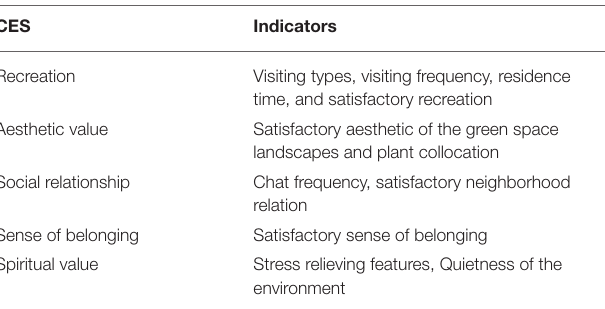
TABLE 1 | Selected CES and their